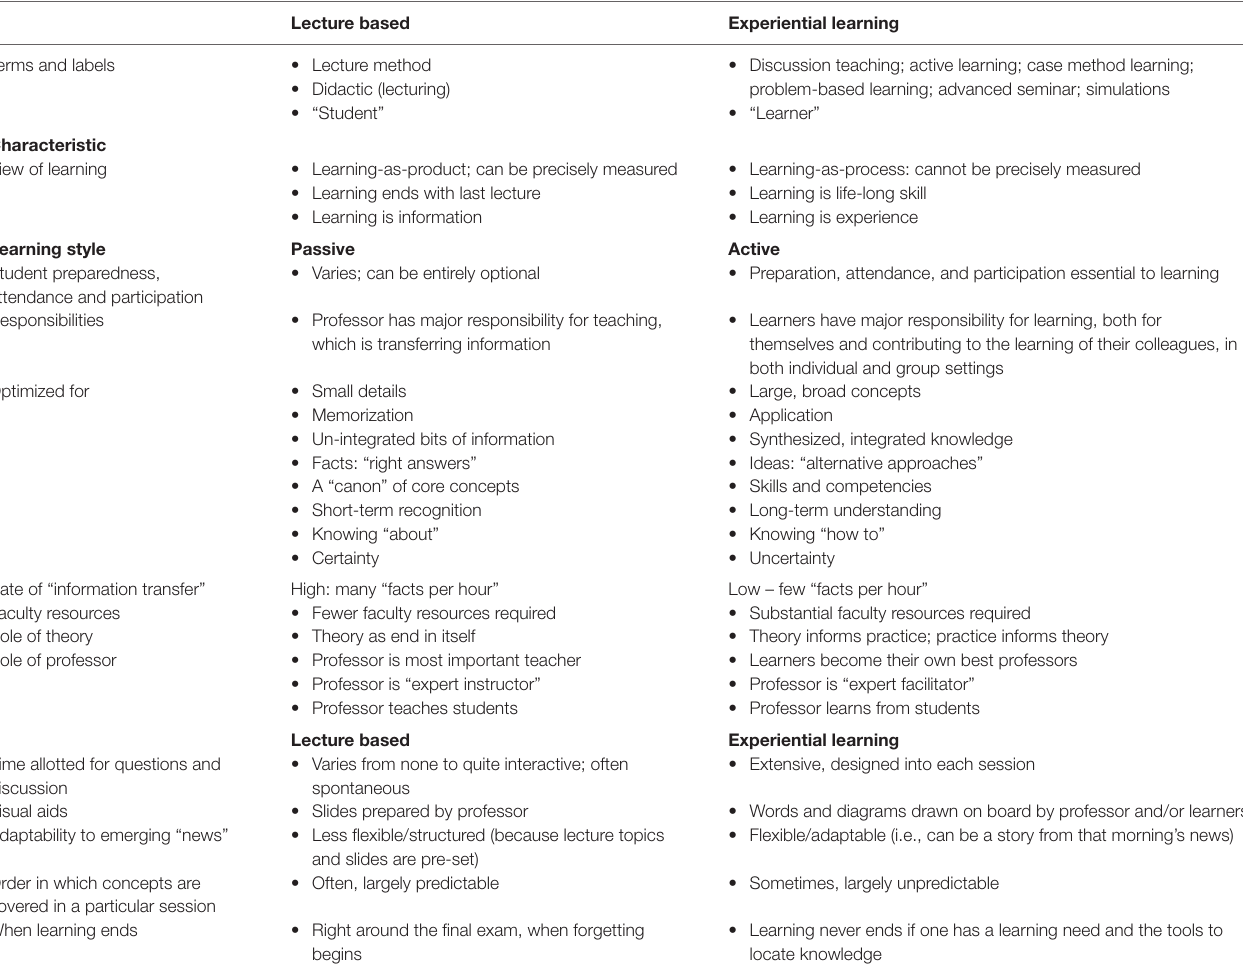
taBle 1 | Contrasting extremes: lecture-based teaching vs. experiential